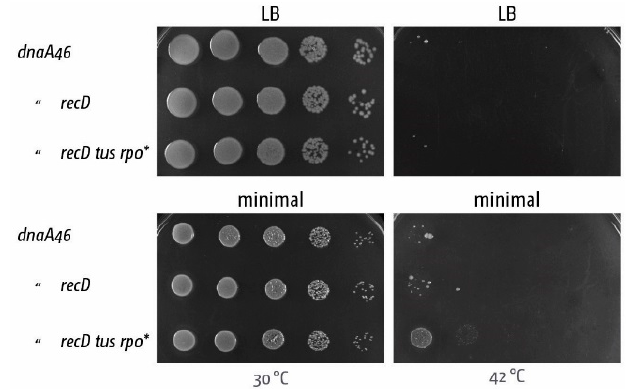
Figure 8. DnaA-independent growth in cells triggered by the absence of RecD contributes very little to cell growth. Spot dilution assay demonstrating that recD contributes little to growth without DnaA ( dnaA46 at 42°C) even in the presence of tus and rpo* mutations (compare with the effect observed in the absence of RecG in Figure 6A).